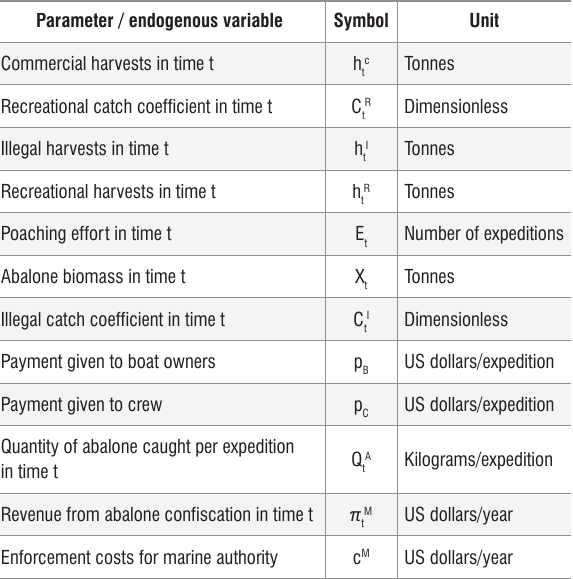
Table 4: Endogenous variables in the model for the South African aba-